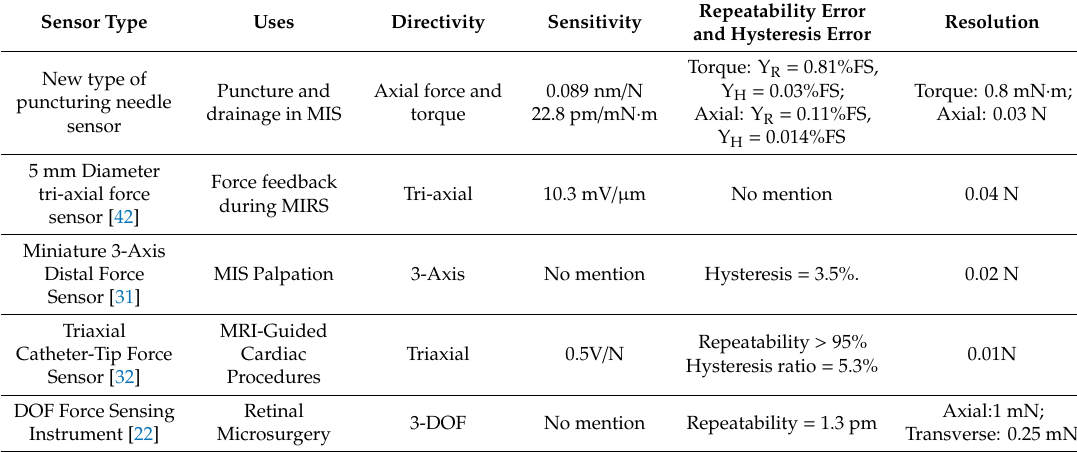
Table 6. Comparative table with the corresponding